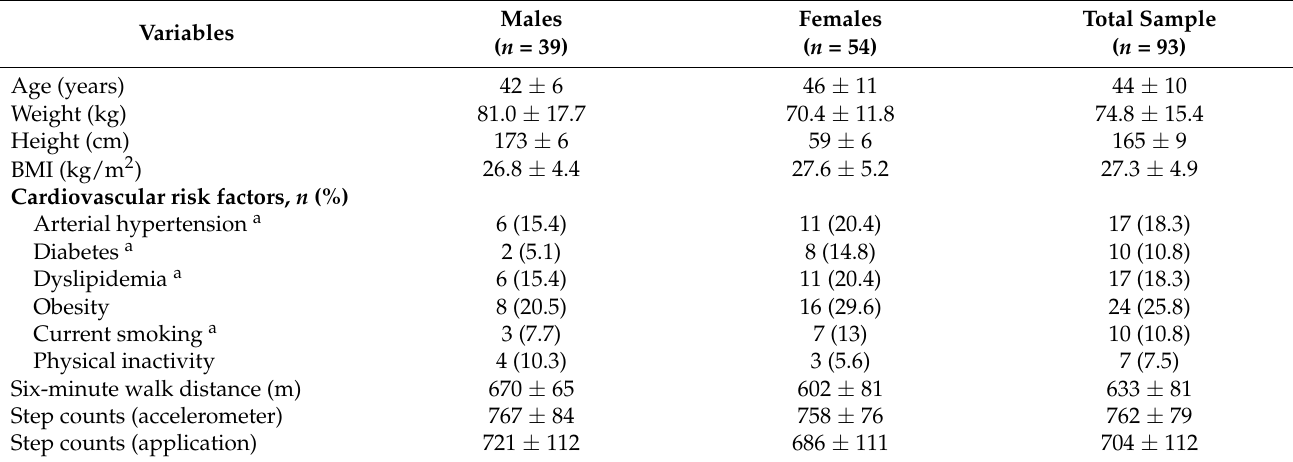
Table 1. General characteristics of sample enrolled in phase 1 to develop the prediction equation for six-minute walk distance ( n =